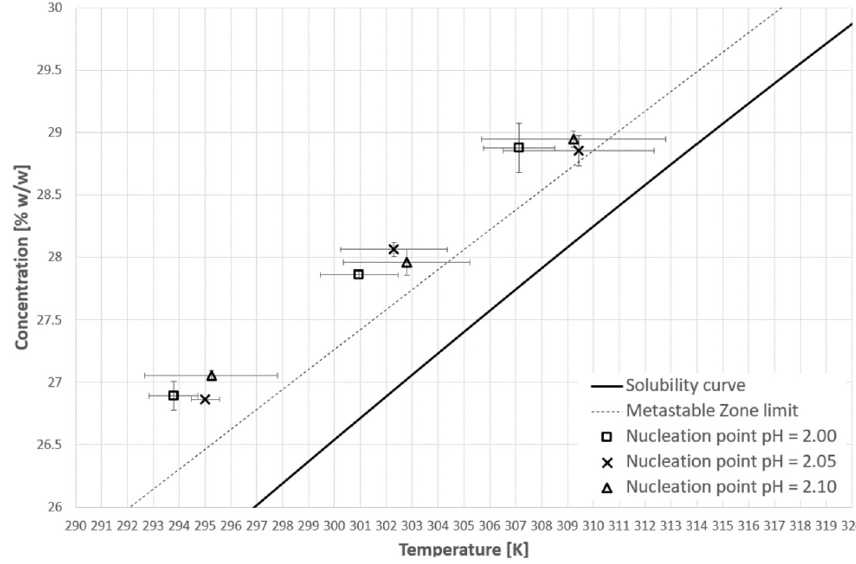
Figure 7. Nucleation point temperatures for the first cooling cycle.